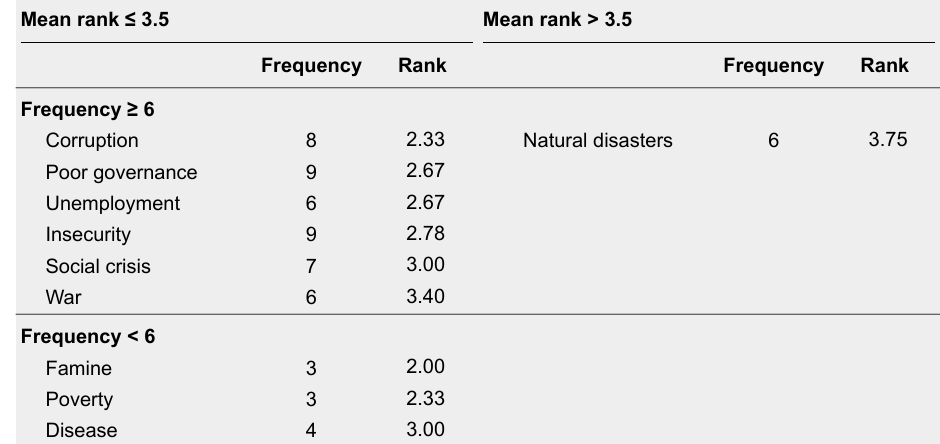
Structure of Risk Representation for Sudano-Sahelian Participants According to Free-Association Analysis (EVOC)